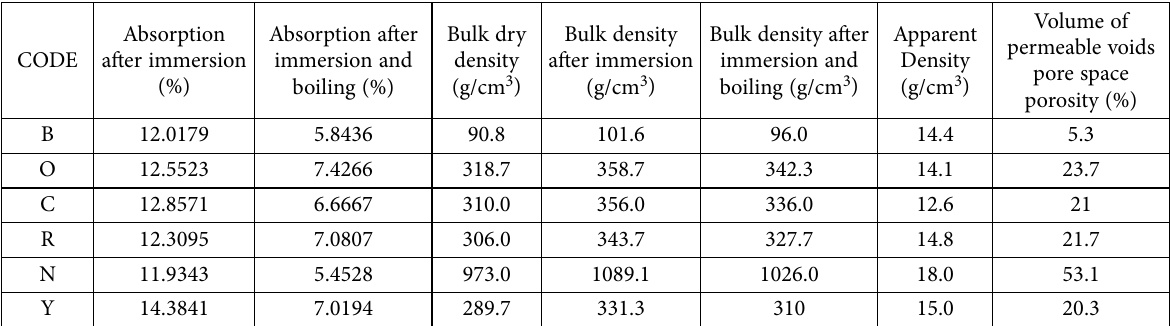
Table 2. Density, absorption and voids results (source: created by the author Akinyemi 2017)